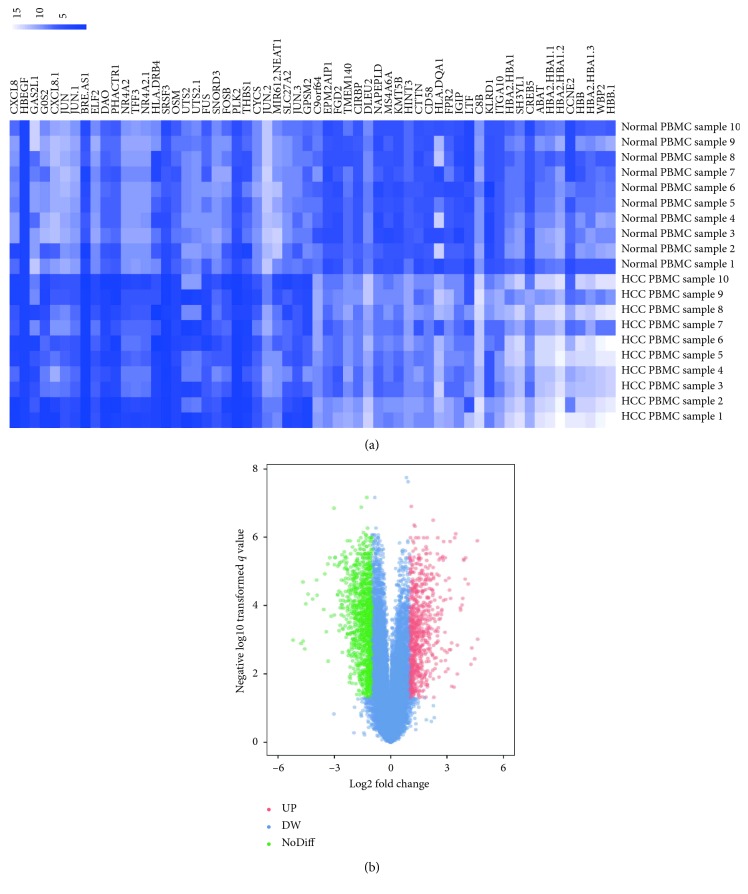
Identification of DEGs of PBMC in GSE49515. (a) Heatmap of the expression levels of the top 50 DEGs employed the GEO2R online analysis tool based on P value < 0.05 and logFC ≤ −2 or logFC ≥ 2 criteria. (b) Volcano plot about total 344 DEGs from GSE49515. The red dots represent 188 upregulated DEGs, while the green dots represent 156 downregulated DEGs. The blue dots denote the no-differentially expressed genes.